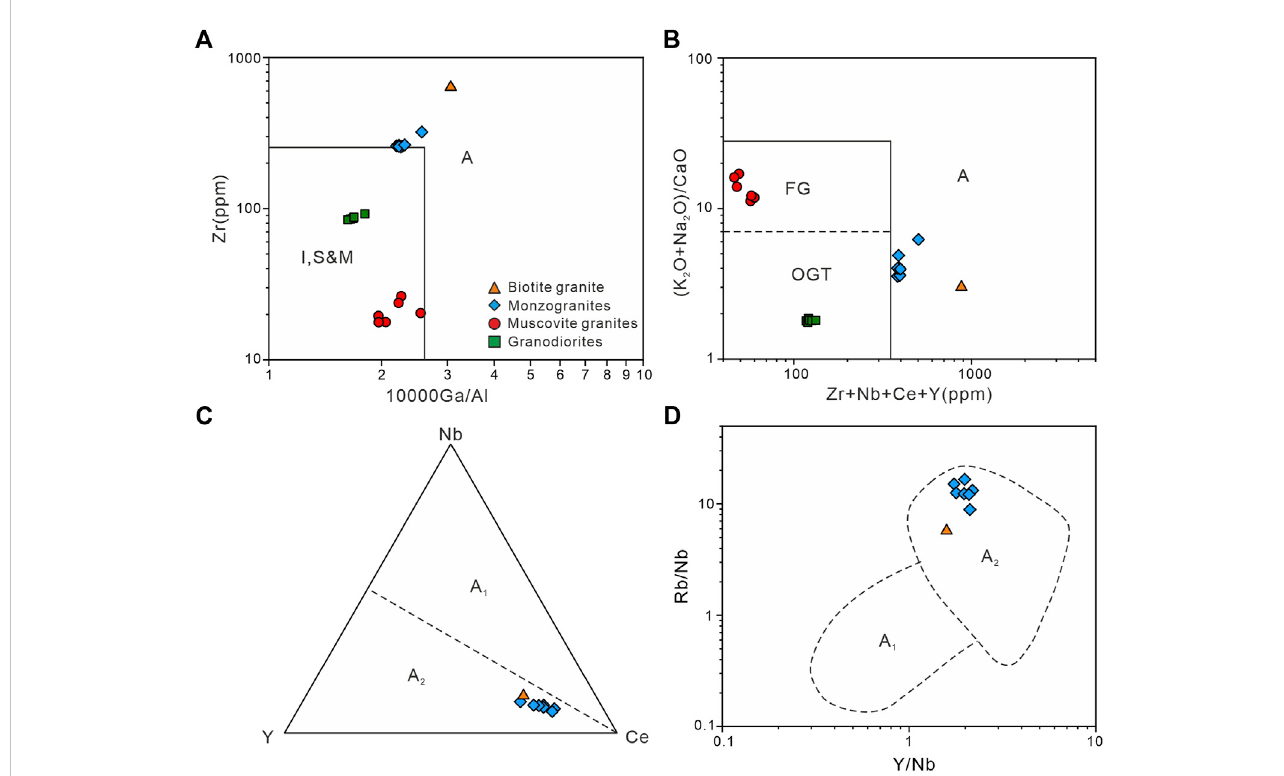
FIGURE 8 (A) Zr vs . 10000Ga/Al and (B) (Na 2 O+K 2 O)/CaO vs . Zr+Nb+Ce+Y discrimination diagrams (Whalen et al., 1987), indicating that the biotite granite and monzogranitesintheHuatugou areaareA-typegranites.FG:Fractionatedgranites;OGT:unfractionatedM-,I-,andS-typegranites. (C) Nb-Y-Ceand (D) Rb/ Nb vs . Y/Nb classi fi cation diagrams (Eby, 1992), where Huatugou biotite granite and monzogranites are plotted in the A 2 fi